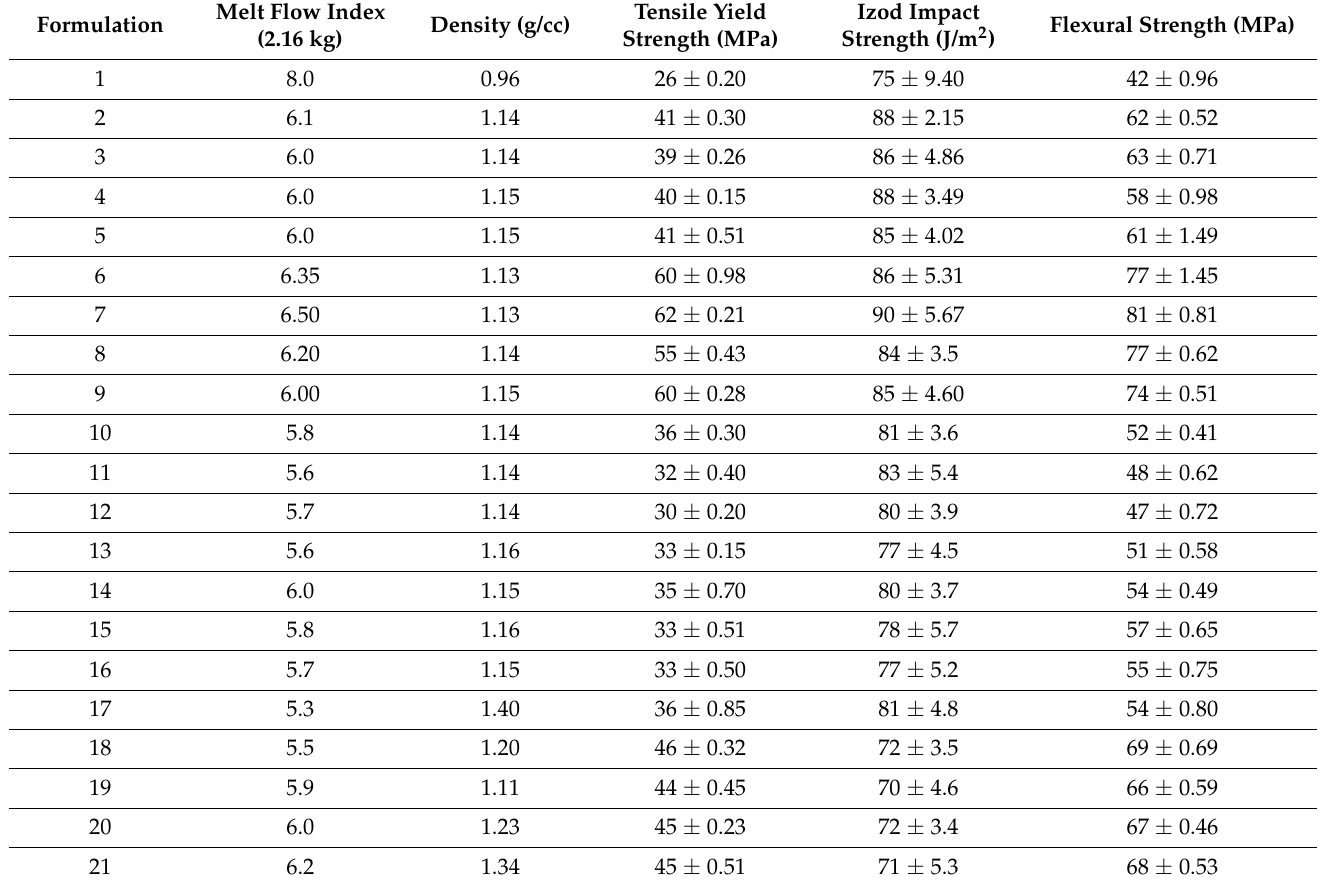
Table 2. Mechanical properties of pure and filled HDPE